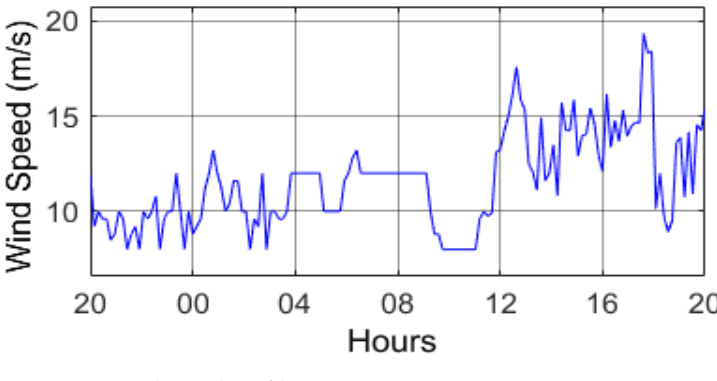
Figure 16. Wind speed profile.